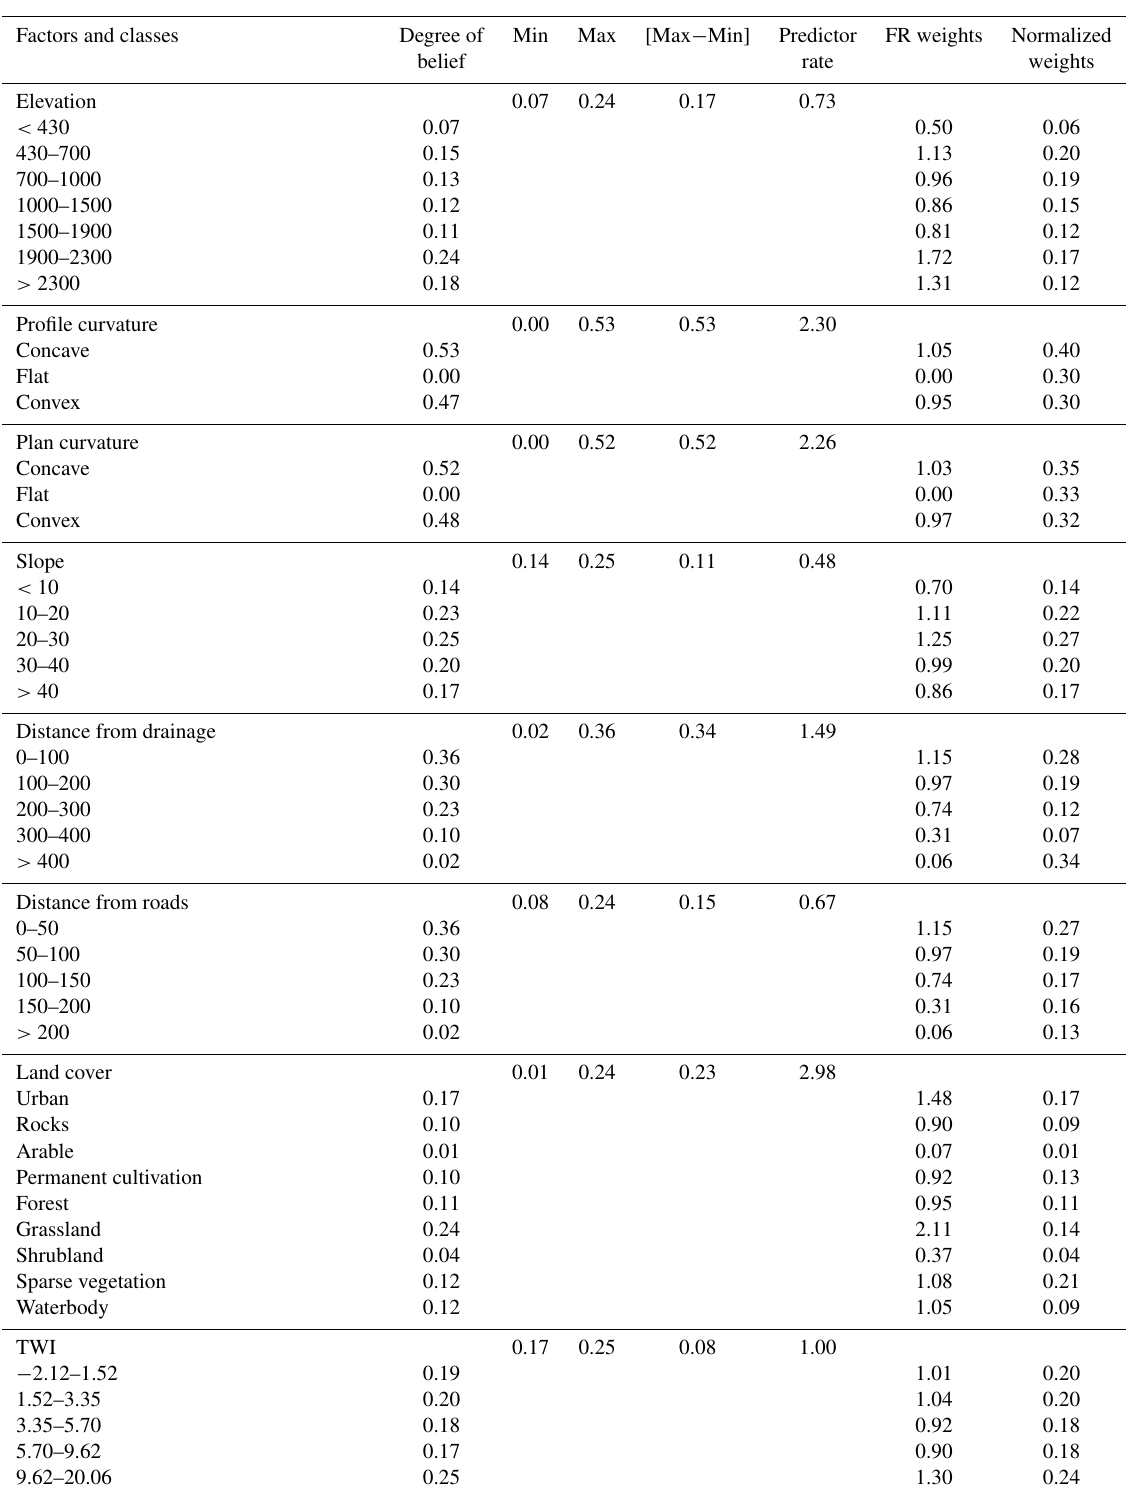
Table 2. Frequency ratio values for spatial factors, class weighting, and EBF coefficients for the predictor rate (PR) based on degrees of spatial